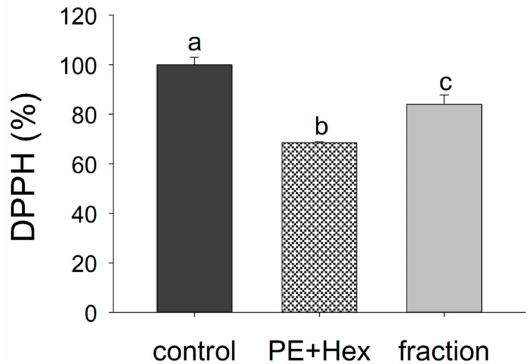
Figure 5. Free radical scavenging activity of the fraction containing 2-pentyl-3,5-dibutyl- dihydropyridine. The reduction of the DPPH signal (520 nm) was recorded for 60 min in the absence (control) and presence of PE (16:0 / 18:1) with hexanal and the collected fraction. Each experiment was performed thrice. Di ff erent letters indicate significant di ff erences. Statistical analysis was performed applying one-way ANOVA with Holm–Sidak post hoc